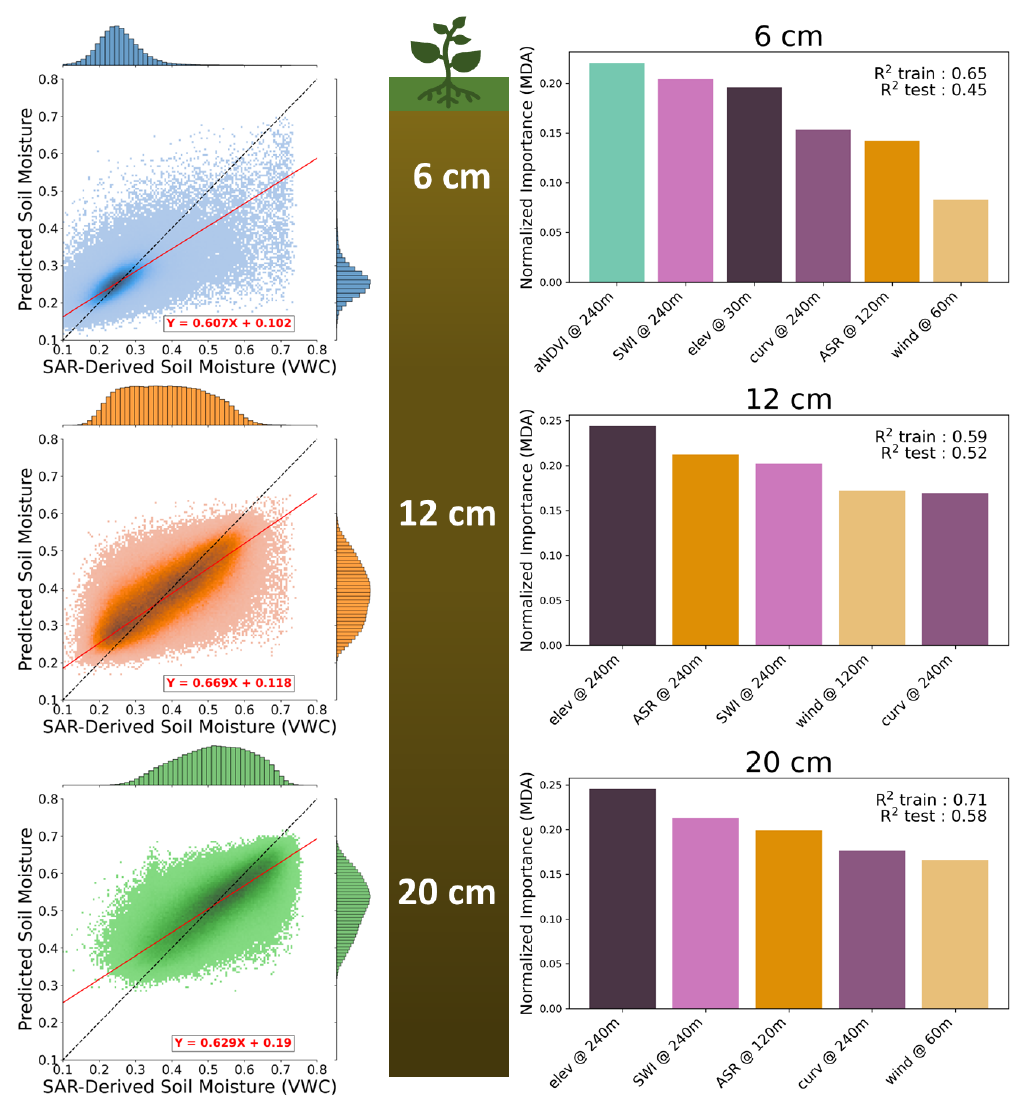
Figure 8. Relationship between SAR-derived soil moisture and random forest soil moisture predic- tions at 6 cm, 12 cm, and 20 cm. The dashed black line is the 1:1, the solid red line is the result of a robust linear regression (Huber), distributions for both the predicted and SAR-derived soil moisture are shown on the sides of the plot. On the right side of the figure are feature importances (MDA) for input features for the final fits at each depth in the soil column.